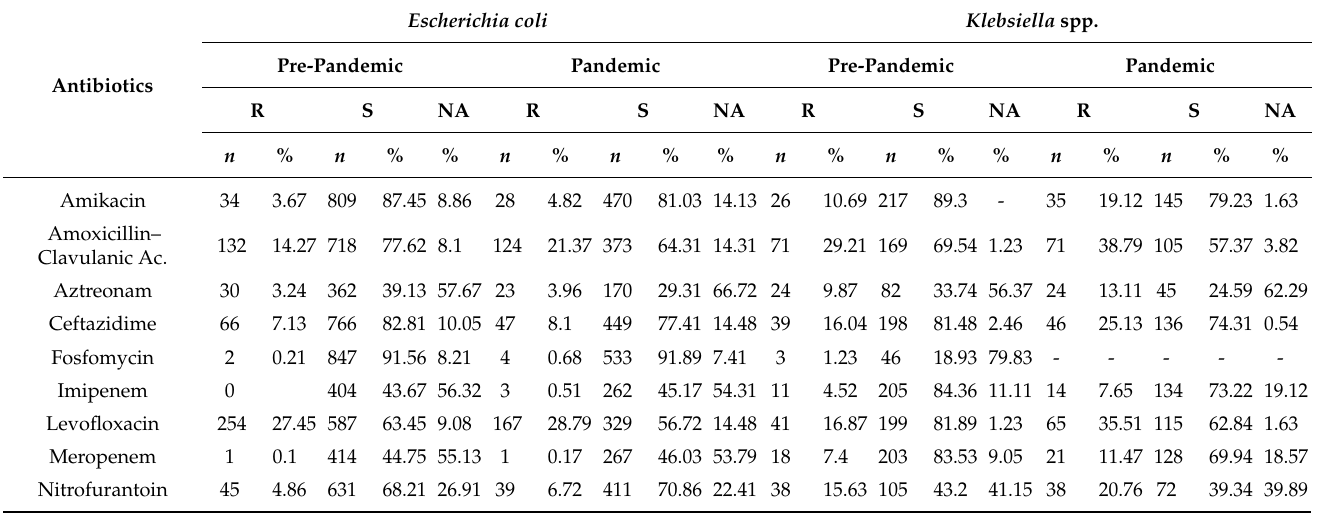
Table 3. Antibiotic resistance profile in Escherichia coli and Klebsiella